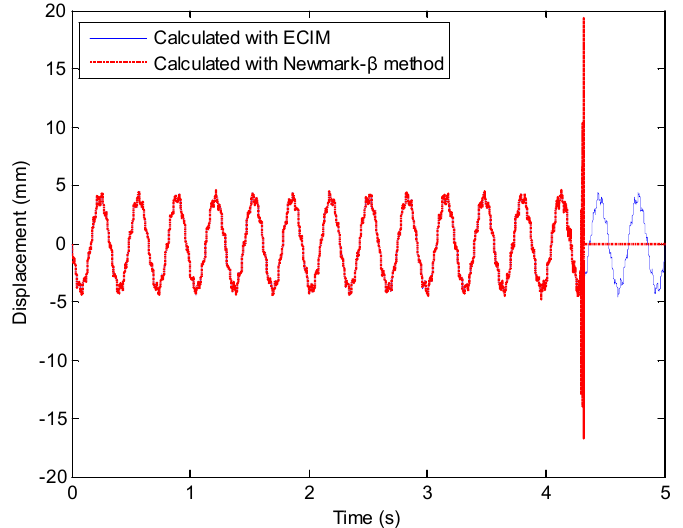
Figure 5. Displacement time history of the free vibration with different integration methods.